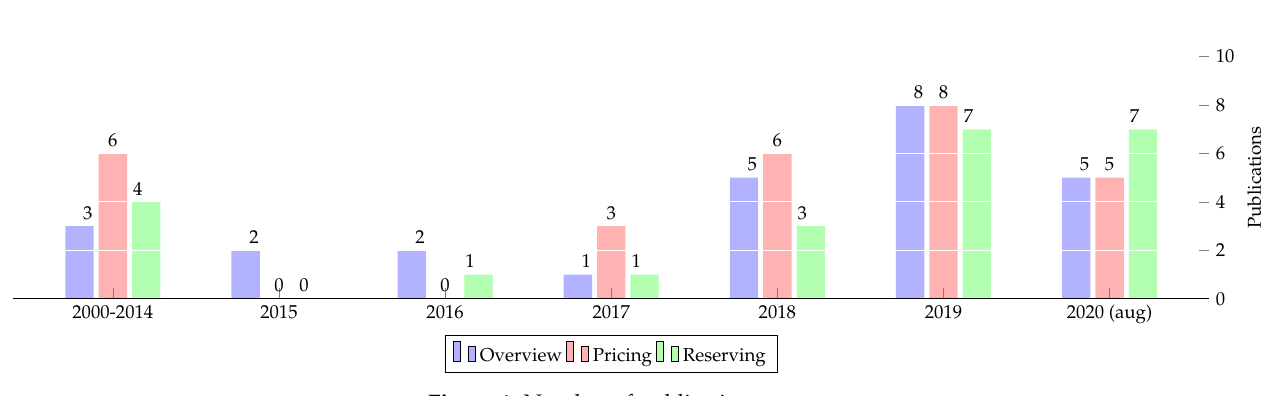
Figure 1. Number of publications per year.